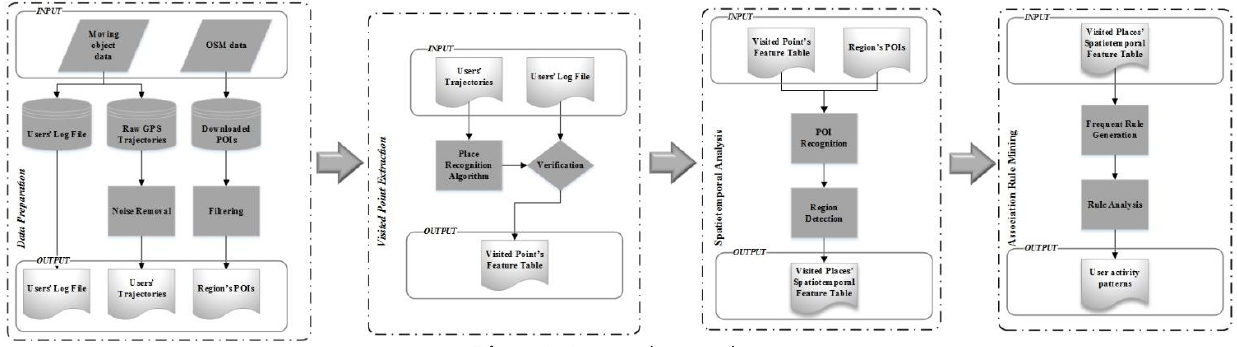
Figure 1. Proposed approach